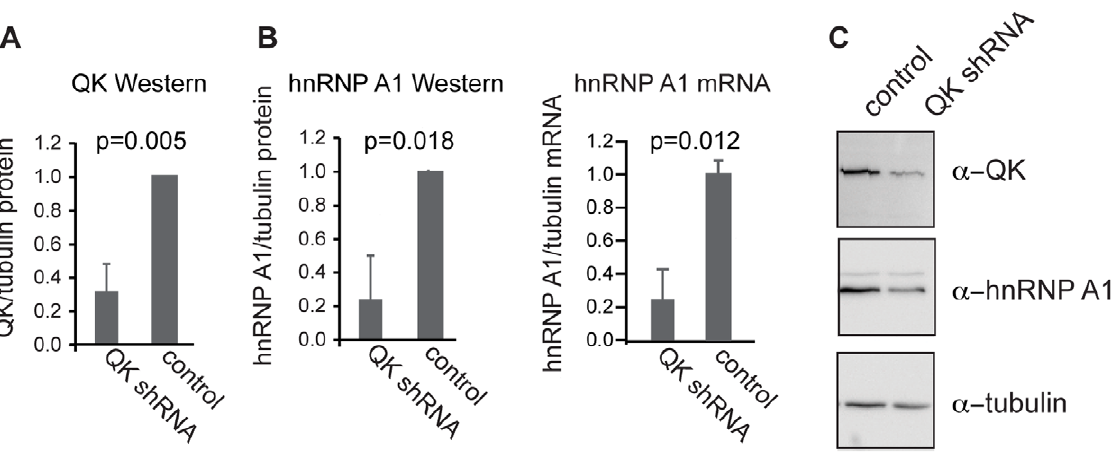
Figure 4. QK regulates expression of endogenous Hnrnpa1 . (A) QK protein was reduced in a CG-4 cell line stably transfected with a construct expressing a Qk shRNA miR compared to a control line expressing a nonsilencing shRNA miR . (B) hnRNP A1 protein was detected by Western blotting and Hnrnpa1 mRNA was detected by real time RT-PCR. Both protein and mRNA were reduced in the QK knockdown line compared to the control line. Tubulin served as a loading control for both assays. (C) Representative Western blot images for the data presented in (A) and (B). Error bars indicate the standard deviation of at least three replicates.